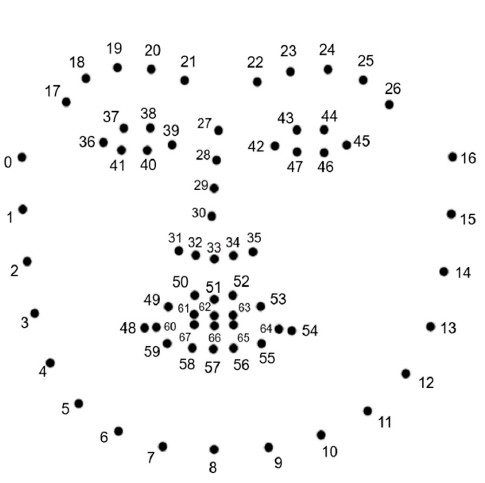
Figure 2. 3D facial landmarks scatter plot and facial landmark’s index numbers.